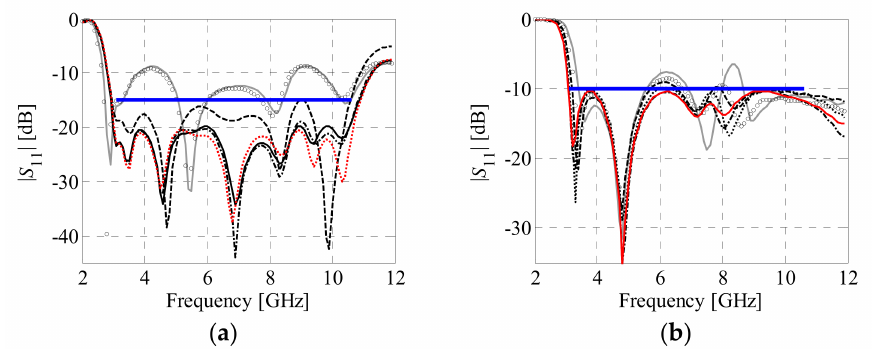
Figure 7. Reflection of the designs optimized in a nested loop with respect to ( a ) objective F 1 and ( b ) objective F 2 . The dimensionalities of the spline-parameterized antenna features (see Section 2) are d 1 = 1 (gray), d 2 = 4 ( ◦◦◦ ), d 3 = 8 (- -), d 4 = 12 ( ··· ), d 5 = 16 ( · - · ), and d 6 = 20 (—), respectively. The gray and red lines represent the characteristics of the initial and final designs obtained in the course of nested optimization. The blue lines denote the threshold values for the design